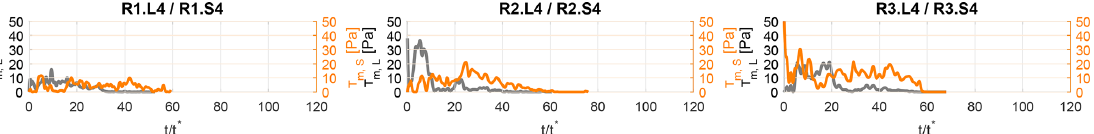
Figure 9. Temporal evolution of interfacial shear stresses calculated by log-law fitting for tests with progressively reduced lock length ( τ m , L ) and with the lock slope ( τ m , S ).